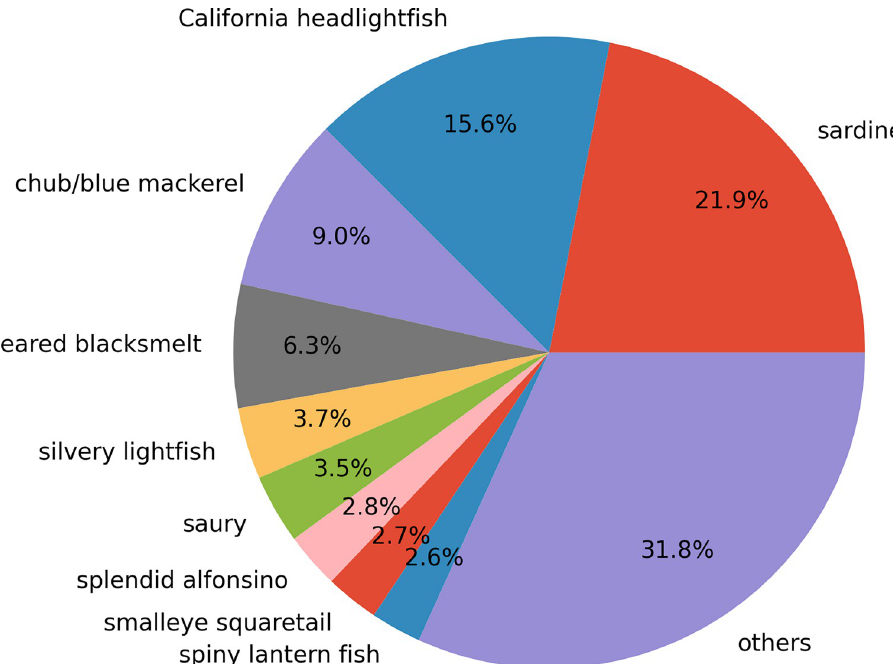
Fig 9. Pie chart based on read percentages of fish species detected by the MiFish method. Here, the pie chart was made based on MiFish data from C-line samples that at least one of sardine, chub/blue mackerel and anchovy was detected by the qPCR method, where sardine = Sardinops melanostictus , California headlightfish = Diaphus theta , chub/blue mackerel = Scomber japonicus + Sc . australasicus , eared blacksmelt = Lipolagus ochotensis , silvery lightfish = Maurolicus muelleri , saury = Cololabis saira , splendid alfonsino = Beryx splendens , smalleye squaretail = Tetragonurus cuvieri , spiny lantern fish = Myctophum spinosum .